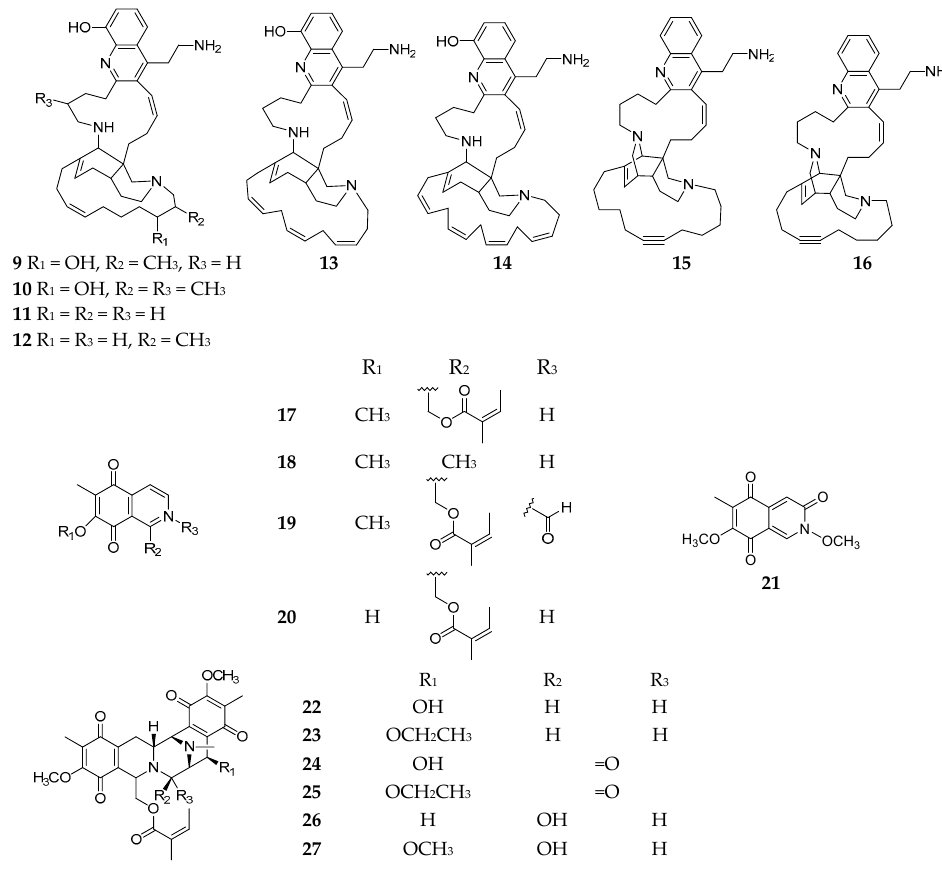
Figure 2. Quinolines and isoquinolines 9 – 27 from the subgenus Reniera. Molecules 2021 , 26 , x FOR PEER REVIEW